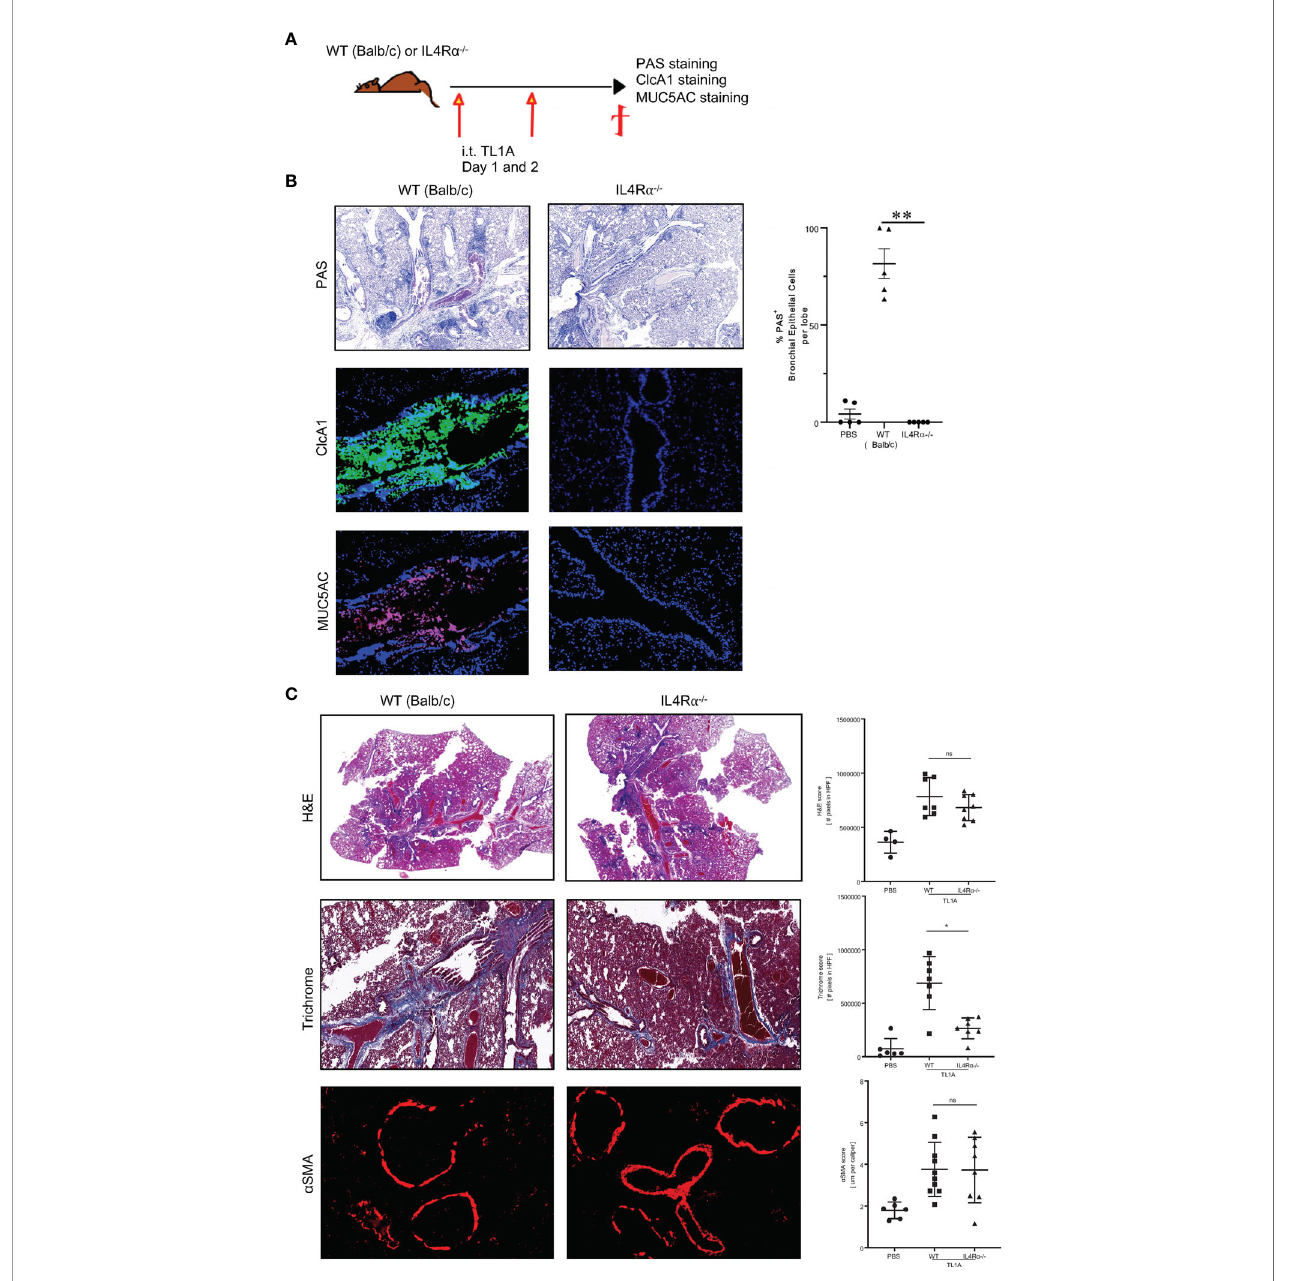
FIGURE 3 | TL1A muco-secretory activity is dependent on IL13/IL4R a signaling. (A) Schematic representation of the protocol used, as previously described in Figure 1 . (B) Top panel: PAS stain of mucus produced in the lungs and quanti fi ed using Image Pro Premier (right panel). Mid and Lower panels: Immuno fl uorescence stains of CLcA1 (green), MUC5AC (red) and nuclear DAPI (blue). (C) In fl ammation assessed by H&E stain (top panels), collagen deposition assessed by trichrome stain (middle panels), and smooth muscle hypertrophy assessed by a SMA immuno fl uorescence stain (red) (bottom panels) on lung biopsies of BALB/c and IL4R a -de fi cient mice induced with PBS or TL1A. Quanti fi cation for each parameter is done using Image Pro Premier. All results representative of three experiments with four to six mice per group. ns, not signi fi cant, *p < 0.05, ** <